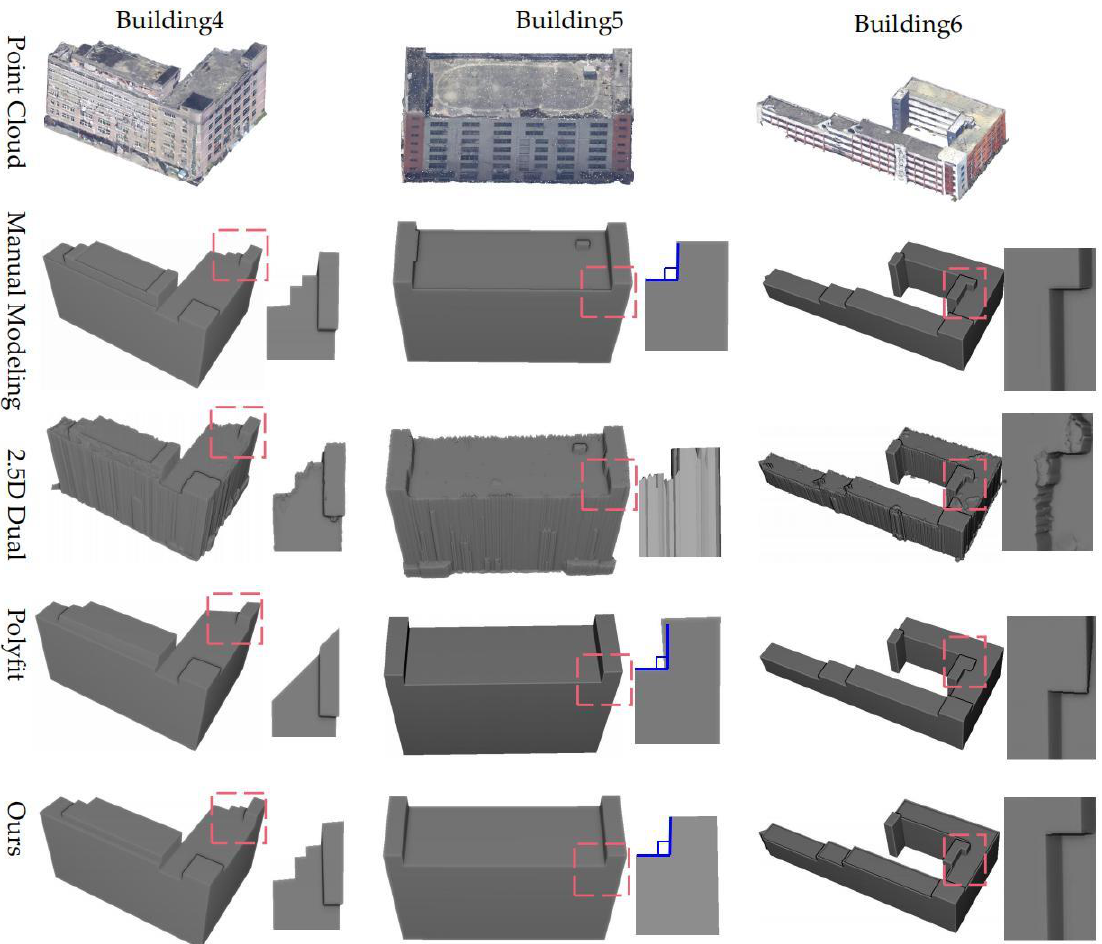
Figure 13. Comparison of models generated using the manual modeling, the 2.5D DC method, the PolyFit method, and our proposed method for Buildings 4, 5, and 6.